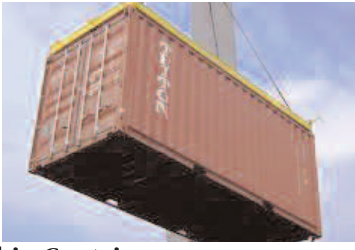
Figure 3. Ship Container Source: http://www.google.com/imgres